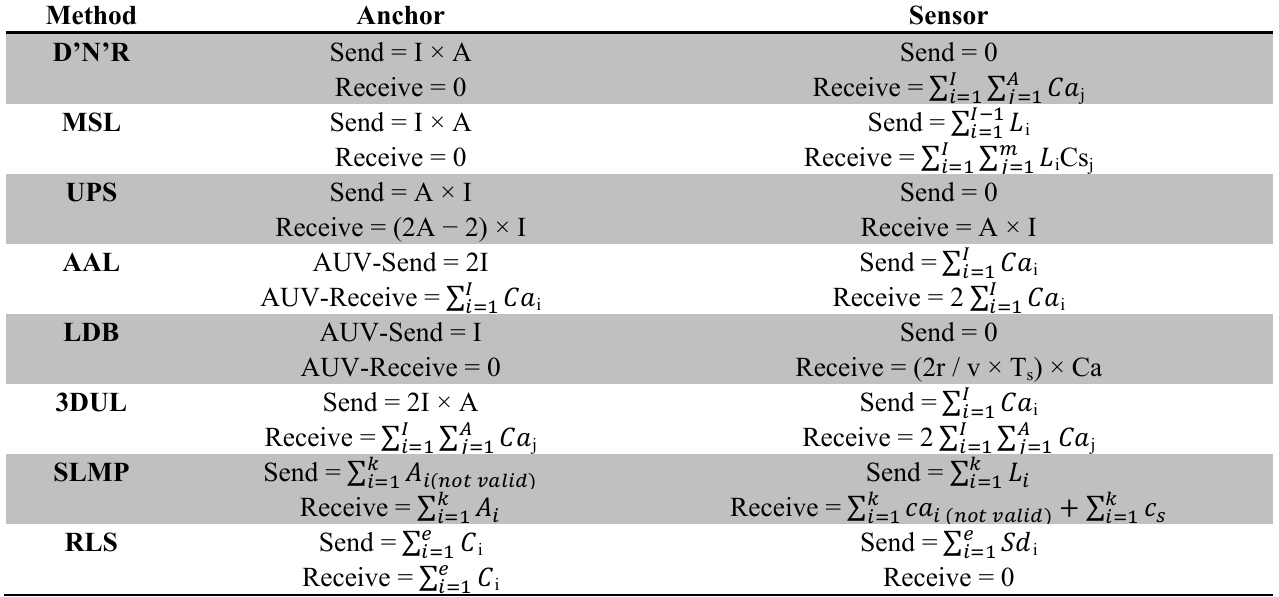
Table 2. Message Exchange Mechanism in Terms of Communication